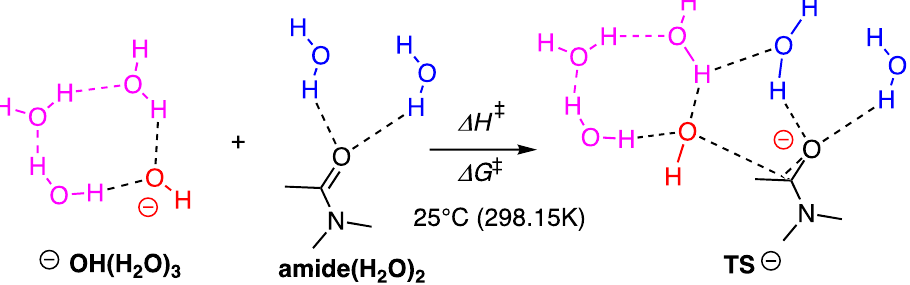
Table 4. Calculated free energy barrier for the formation of the transition state at 25 °C (298.15 K) at the M06-2X/6-31+G(d) and M06-2X/6-311++G(d, p) levels, considering five water molecules.